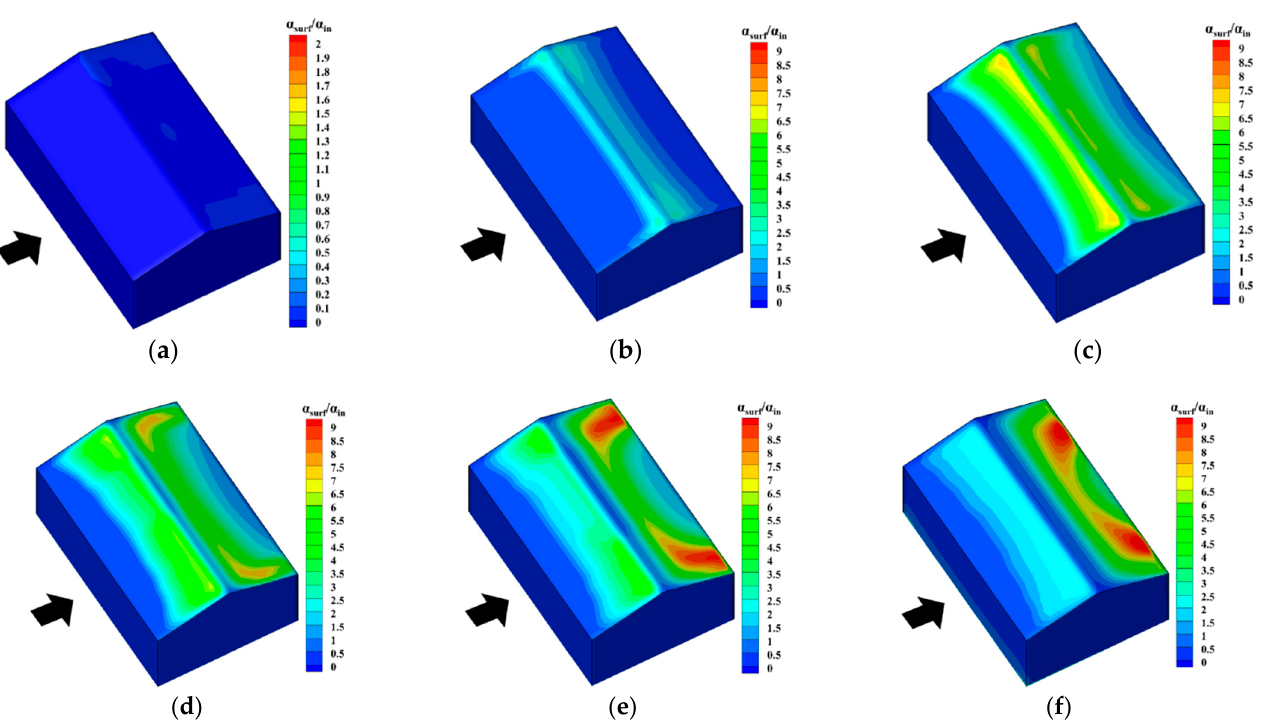
Figure 13. Normalized friction velocity u ∗ / u ∗ t : ( a ) U H = 2 m/s; ( b ) U H = 3 m/s; ( c ) U H = 4 m/s;